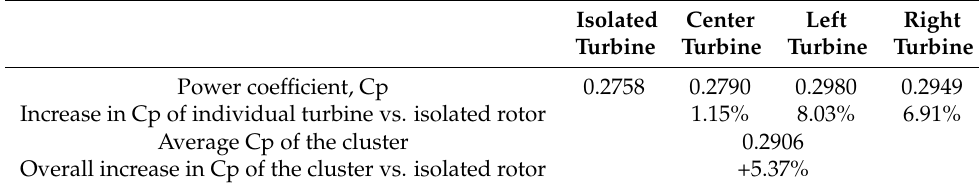
Table 4. Simulation results at 4 turbine diameter